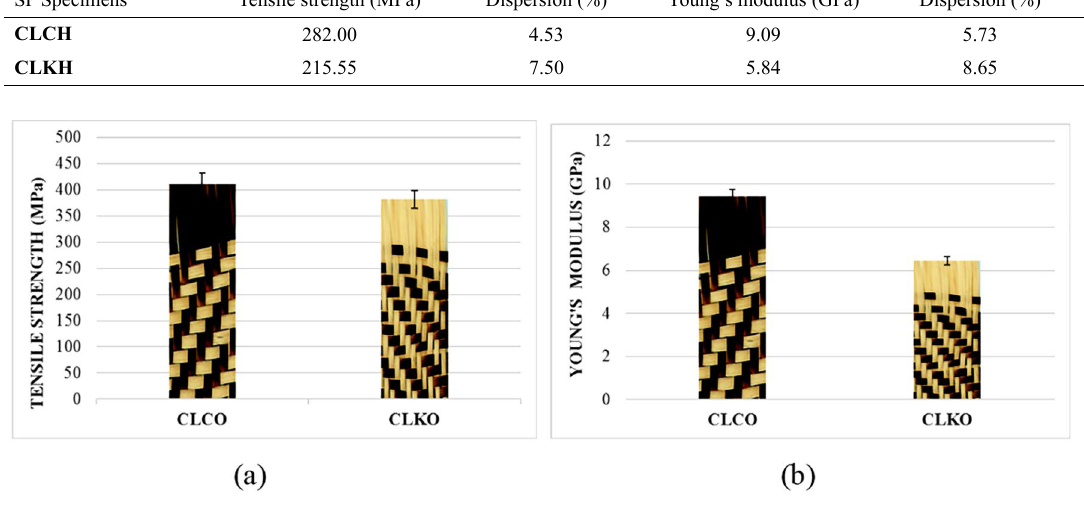
Figure 4. Comparative graph of the composite laminate ( CL ) as a function of anisotropy. (a) Tensile strength. (b) Young’s modulus. of a central hole in composite laminates changes the rigidity behavior of these materials 11,13